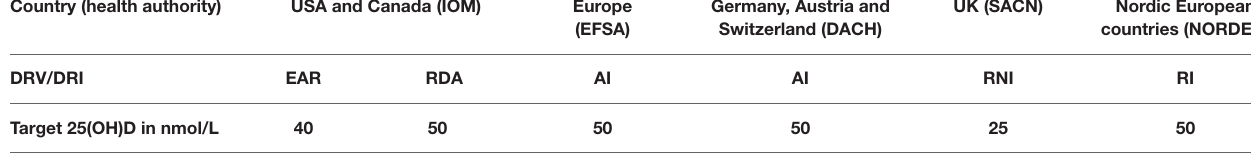
TABLE 1 | Dietary reference values (DRV)/dietary reference intakes (DRI) for vitamin D. Country (health